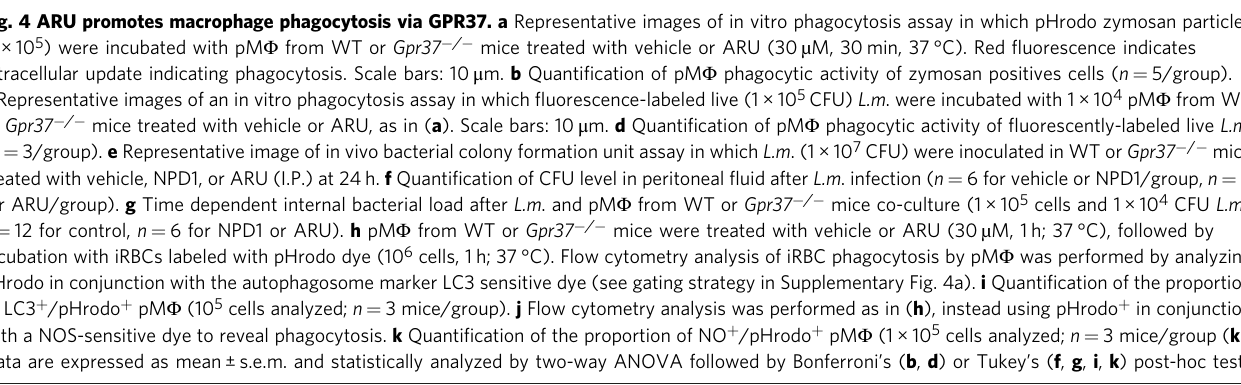
Fig. 4 ARU promotes macrophage phagocytosis via GPR37. a Representative images of in vitro phagocytosis assay in which pHrodo zymosan particles (1 × 10 5 ) were incubated with pM Φ from WT or Gpr37 − / − mice treated with vehicle or ARU (30 µ M, 30 min, 37 °C). Red fl uorescence indicates intracellular update indicating phagocytosis. Scale bars: 10 μ m. b Quanti fi cation of pM Φ phagocytic activity of zymosan positives cells ( n = 5/group). c Representative images of an in vitro phagocytosis assay in which fl uorescence-labeled live (1 × 10 5 CFU) L.m . were incubated with 1 × 10 4 pM Φ from WT or Gpr37 − / − mice treated with vehicle or ARU, as in ( a ). Scale bars: 10 μ m. d Quanti fi cation of pM Φ phagocytic activity of fl uorescently-labeled live L.m . ( n = 3/group). e Representative image of in vivo bacterial colony formation unit assay in which L.m . (1 × 10 7 CFU) were inoculated in WT or Gpr37 − / −